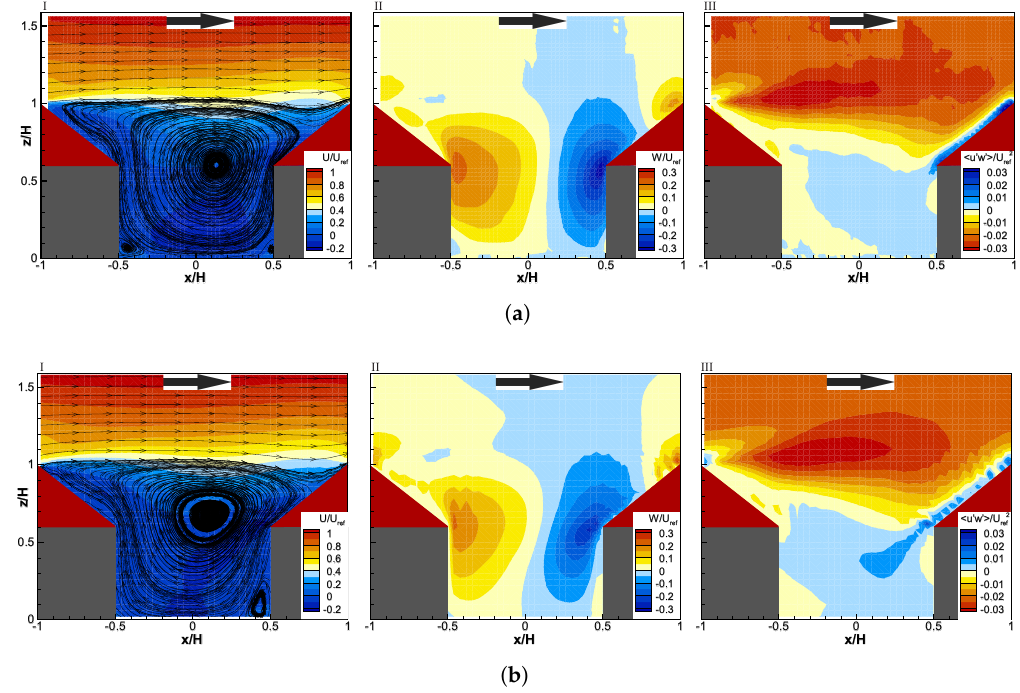
Figure 3. The mean dimensionless streamwise velocity with streamlines (first column) and vertical (second column) velocity, and momentum flux (third column) for ( a ) PIVa; and ( b ) LESa. This corresponds with the notably streamwisely tilted pattern of the simulated vertical velocity field in the second column of Figure 3b, compared to the experiment. Another important observation can be interpreted from the fields of the momentum flux (third column in Figure 3a,b), namely the LES very well predicts the vortex shedding in the roof-top region but it over-predicts the positive streamwise momentum flux within the canyon. As will be shown later in Section 5.3, the vortex in the roof-top region is part of a rather large-scale and smooth up-roof flow, which is well simulated by the LES in general. The zone inside the canyon, on the other hand, consists of many small vortices and shear patterns under the spatial resolution of the LES